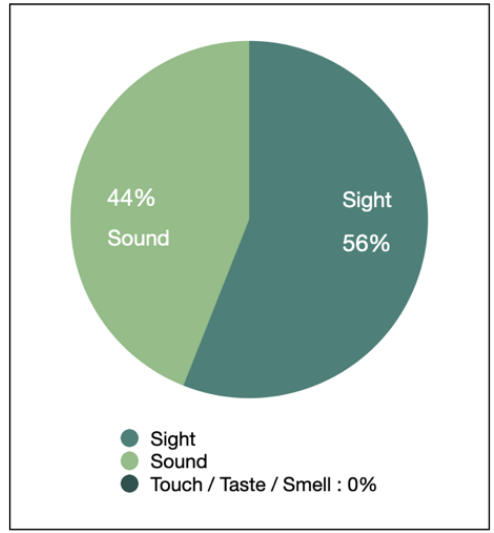
Figure 1. The five senses in interaction.